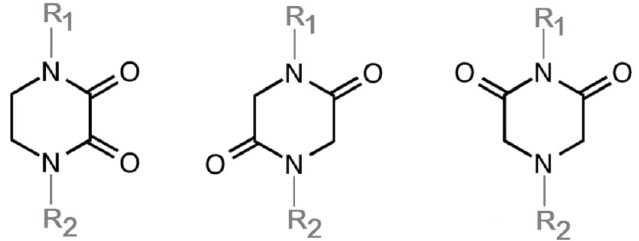
Figure 1. Structure of 2,3 ‐ DKP ( left ), 2,5 ‐ DKP ( middle ) and 2,6 ‐ DKP ( right ) rings as important pharmacophores.